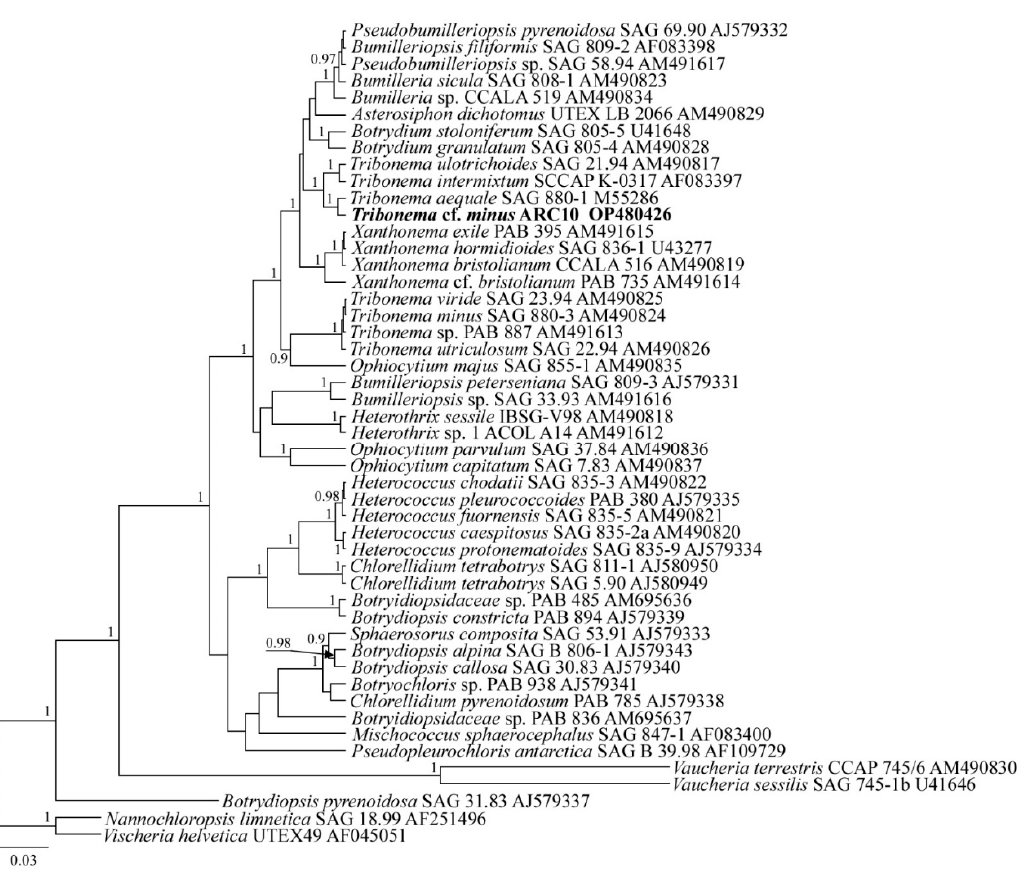
Figure 9. Phylogenetic position of the strain Tribonema cf. minus ARC10 (indicated in bold) based on Bayesian inference for the partial 18S rRNA gene. Total length of the alignment is 1041 characters. Posterior probabilities exceeding 0.9 of BI (constructed by Beast) are presented in order on the nodes. Strain numbers (if available) and GenBank numbers are indicated for all sequences.